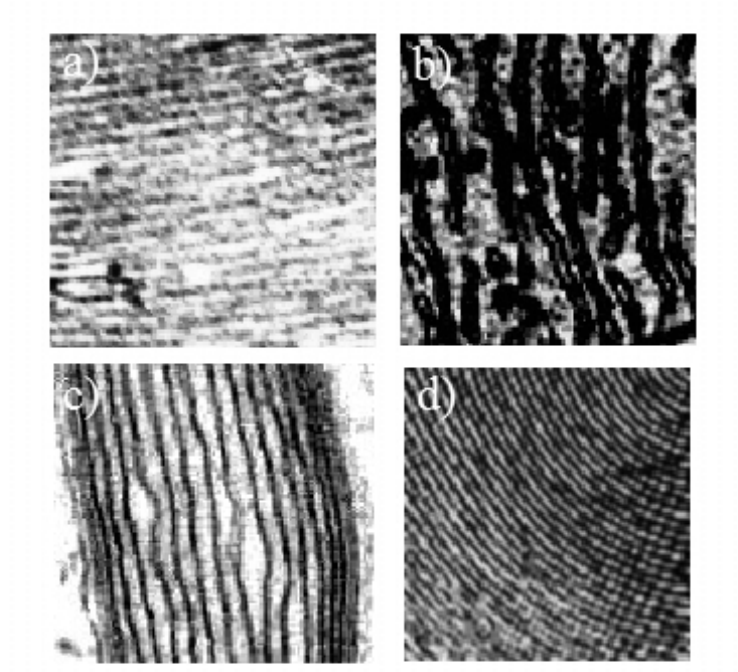
Figure 3. The superlattice of water layers intercalated by lipid bilayers measured by